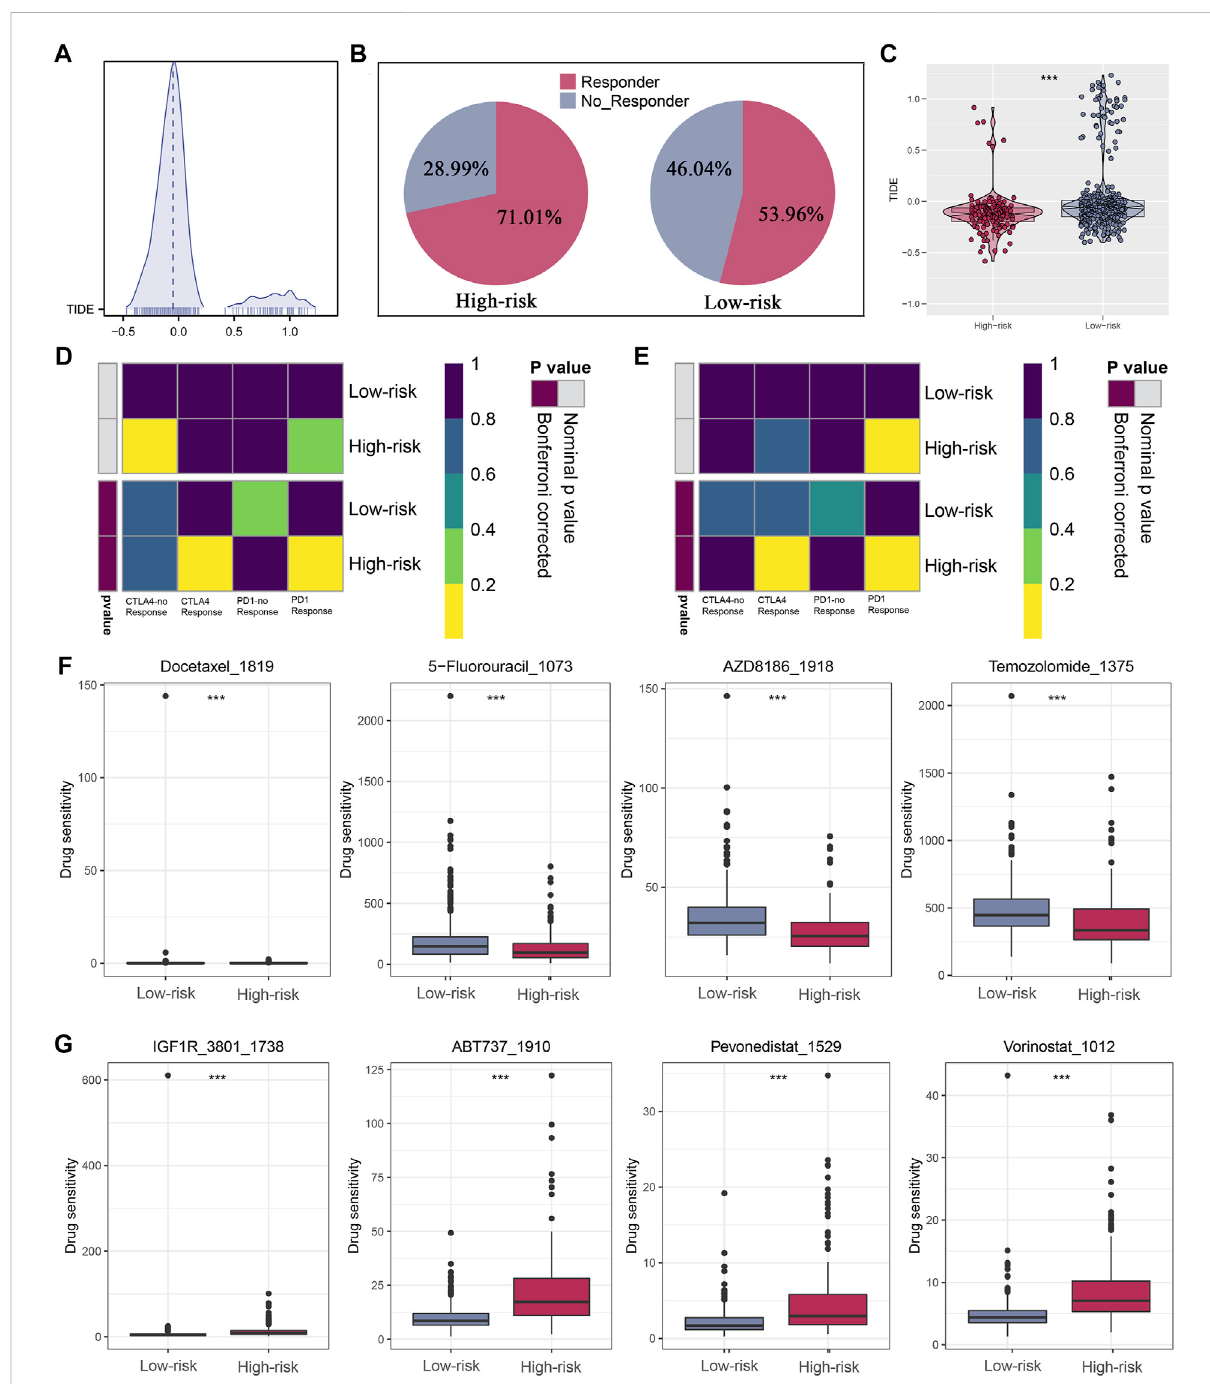
FIGURE 8 Immunotherapeuticresponsepredictionandscreeningofpotentialdrugs. (A) DistributionofTIDEscore. (B) Patientsinthehigh-riskgrouphave a higher percentage of responders. (C) Patients in the high-risk group have a lower level of TIDE score. (D,E) Subclass mapping analysis indicated patients in the high-risk group could be more sensitive to the PD-1 inhibitor in both LGG and GBM. (F,G) Drugs with the most signi fi cant sensitivity differences in high- and low-risk